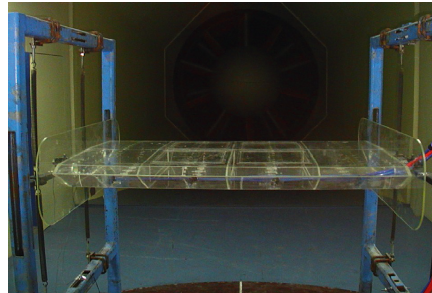
Figure 4: The tested model and the free vibration device.